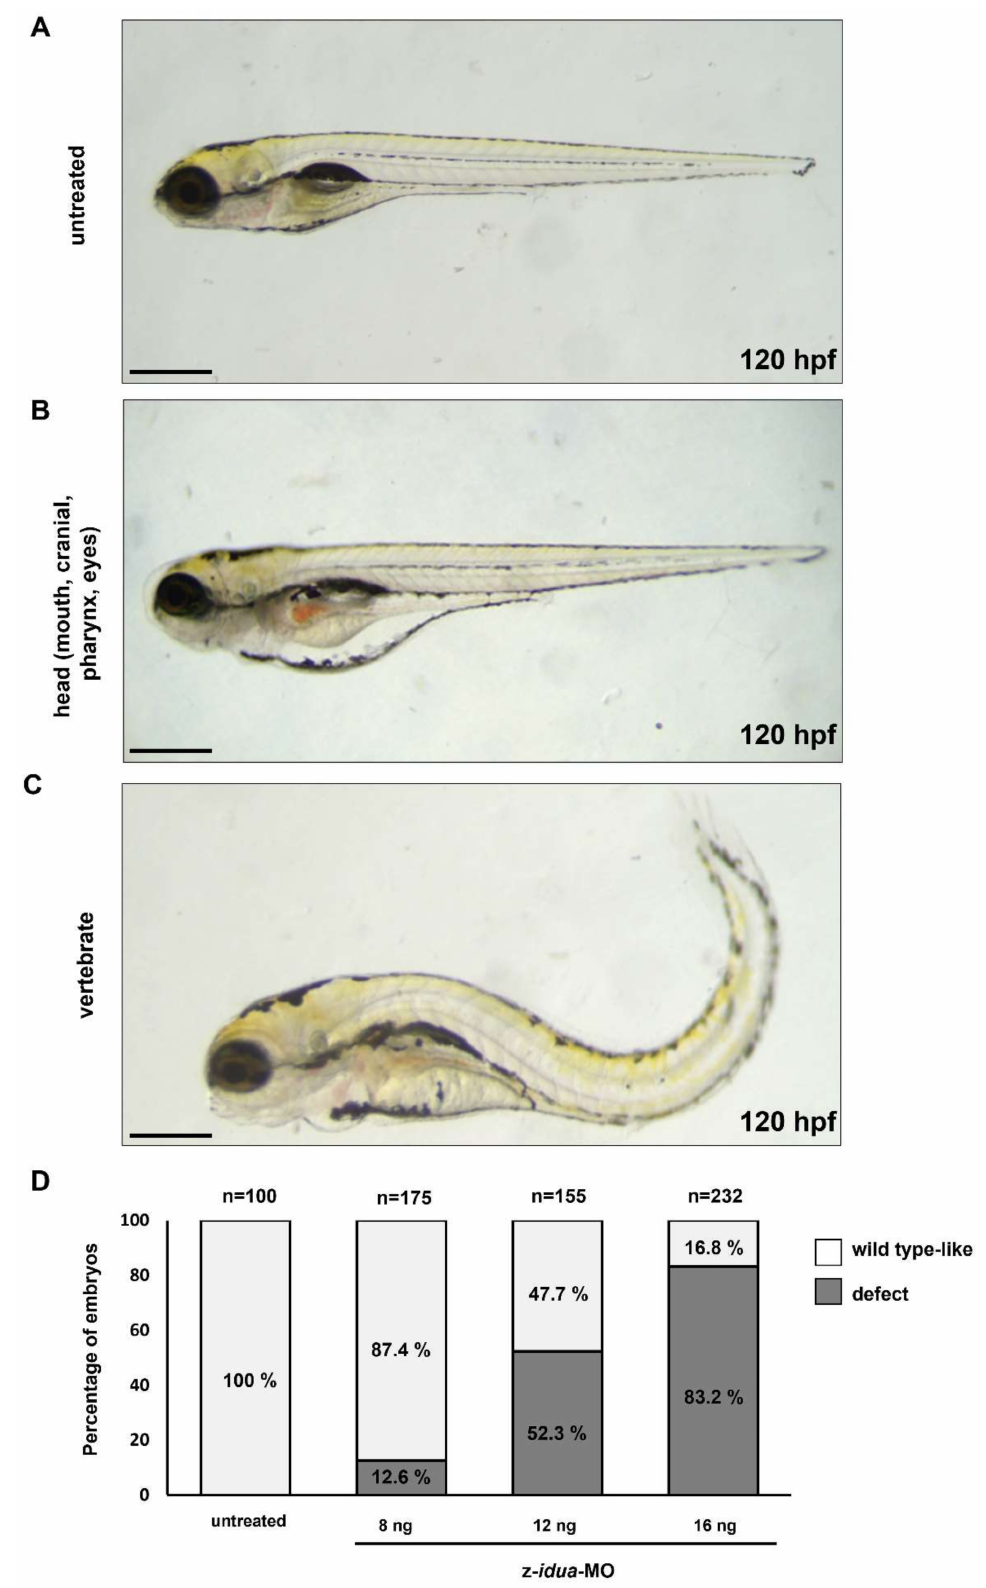
Figure 3. Knockdown of z- idua caused defective development in zebrafish embryos. Embryonic phenotypes were observed in 120 hpf zebrafish embryos injected with 12 ng z- idua -MO. ( A )